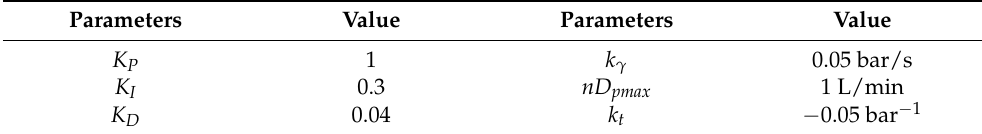
Table 2. Main control parameters of the controller. Parameters